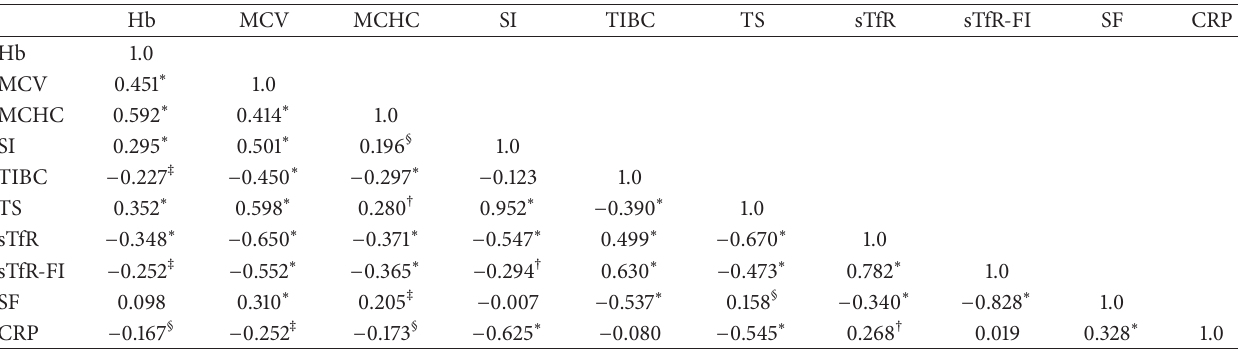
Table 5: Spearman’s correlation coefficients ( 𝑅 ) between the different iron status indicators ∗ .